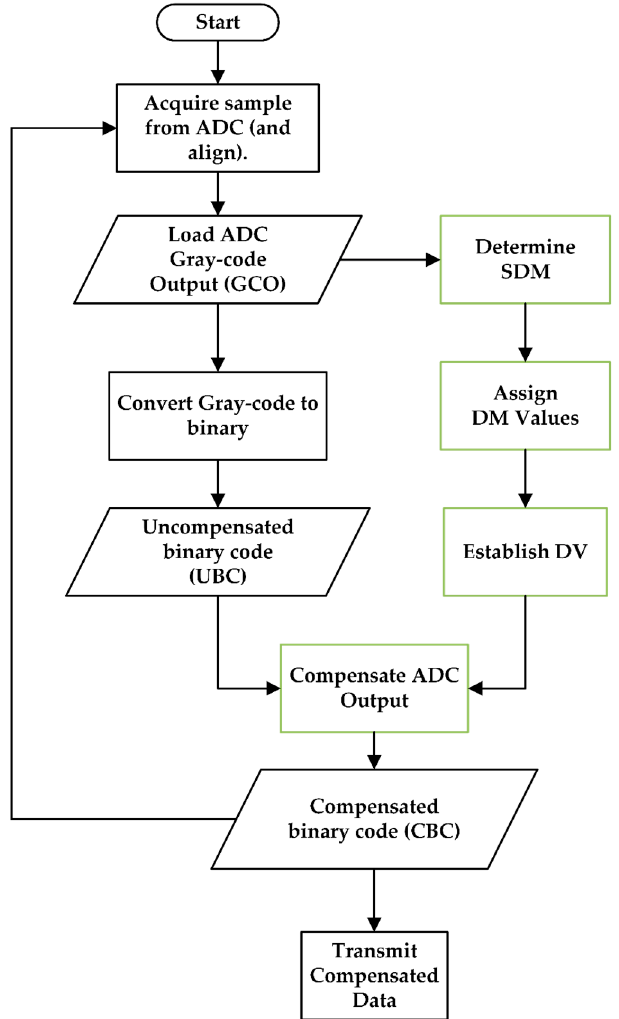
Figure 5. A flowchart giving an overview of the algorithm and its implementation.